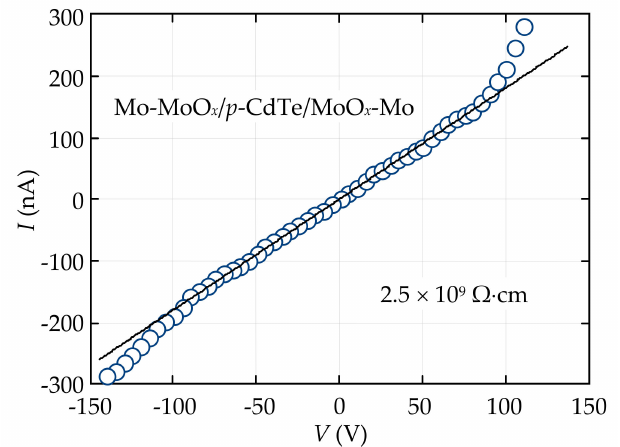
Figure 1. I-V characteristics of the Mo-MoO x / p -CdTe/MoO x -Mo detector with two ohmic contacts at both polarities of applied voltage (circles). The solid line demonstrates a linear voltage dependence of the